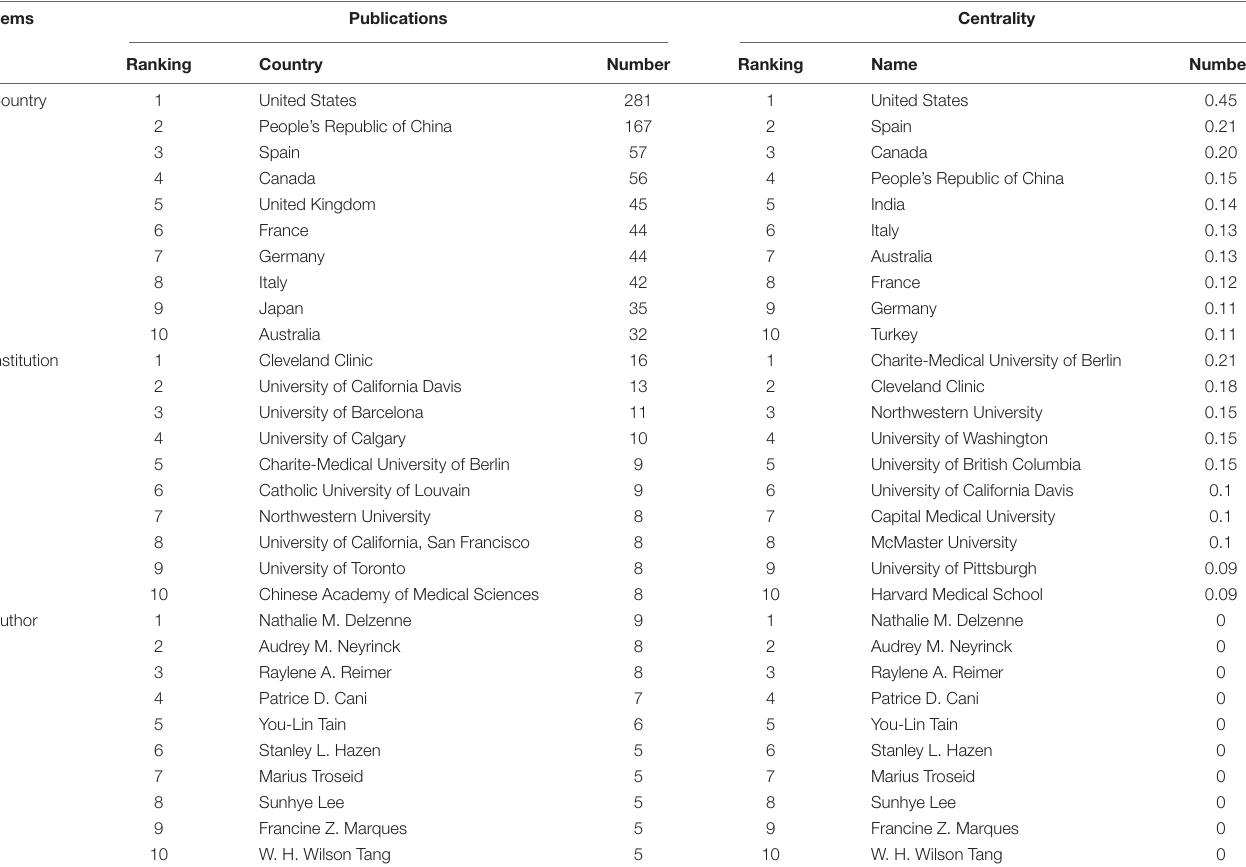
TABLE 1 | Ranking of the top 10 countries, institutions, and authors based on publications and centrality. Items Publications Centrality Ranking Country Number Ranking